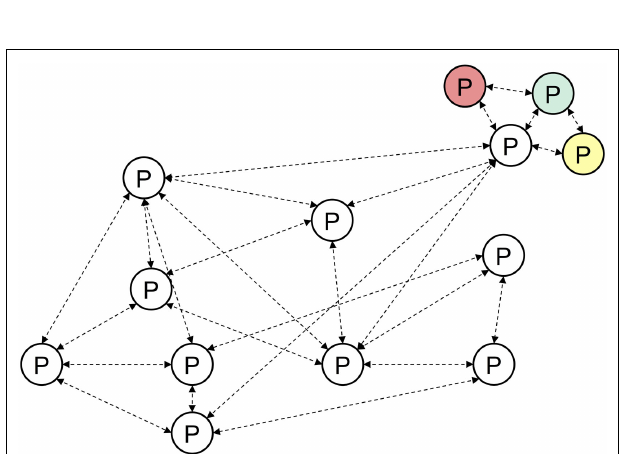
FIGURE 6 | Joint episodic-procedural memory as an explicit network of associations between perceptions and actions, drawn from episodic and procedural memories, unwinding the temporal and causal relationships between specific perceptions and actions that are implicit in the mappings of other perceptuo-motor representations .